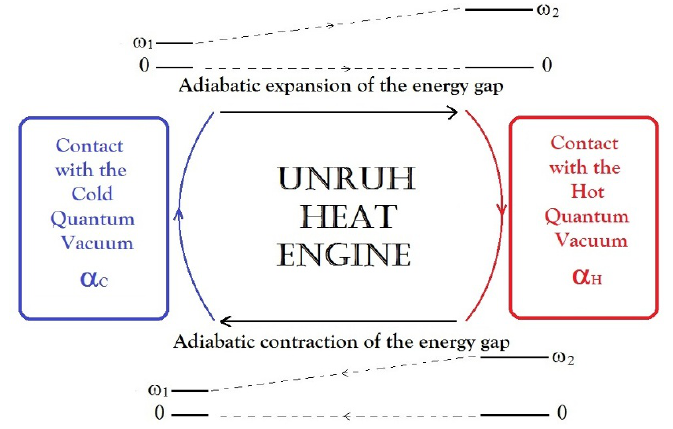
Figure 1. The Unruh quantum thermodynamic